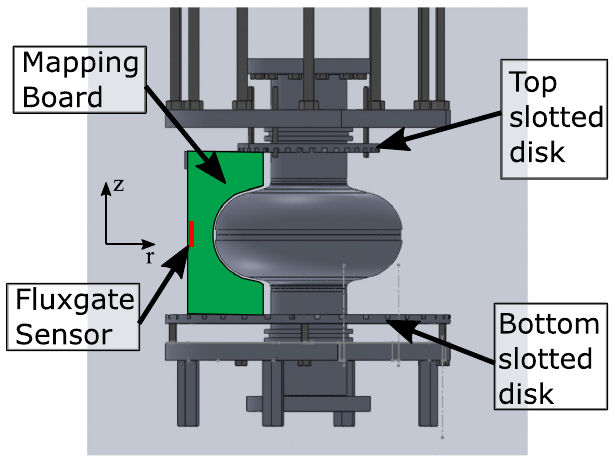
FIG. 1. Schematic model of the mapping board setting for the single cell 1.3-GHz cavity. The cavity was suspended on an aluminum plate jig. The top and bottom slotted disks constrained the mapping boards to fix the vertical axis. The solenoid coil covered the cavity and mapping board to control the vertical axis magnetic field (see Fig. 3). Four fluxgate sensors were mounted every 90° on the outer surface of the boards as a reference value of the magnetic